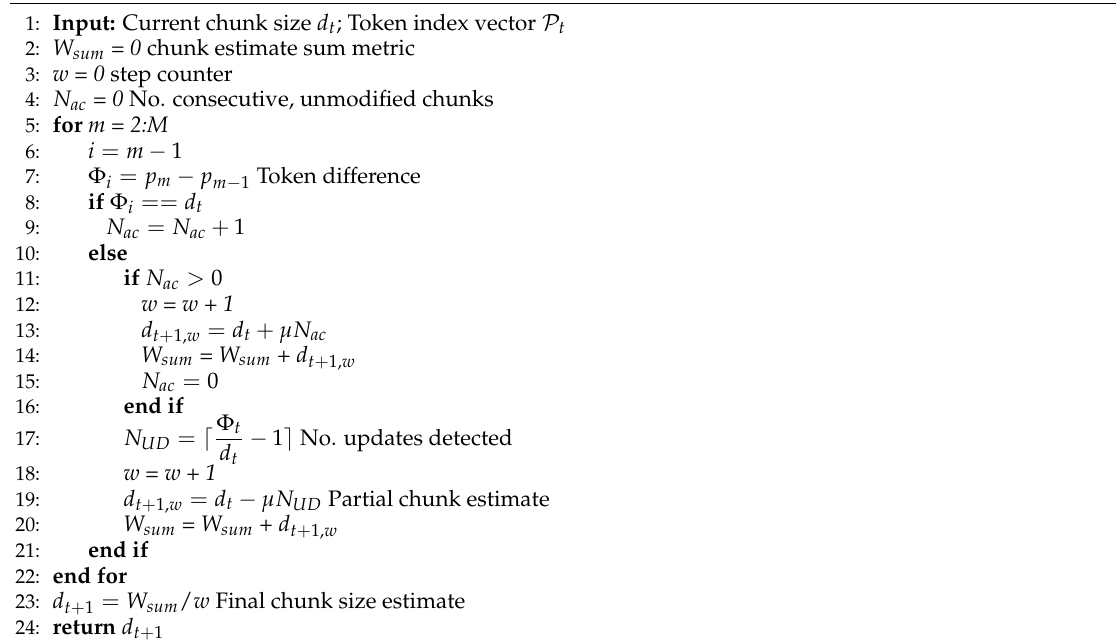
Algorithm 1 Procedure for adapting the chunk